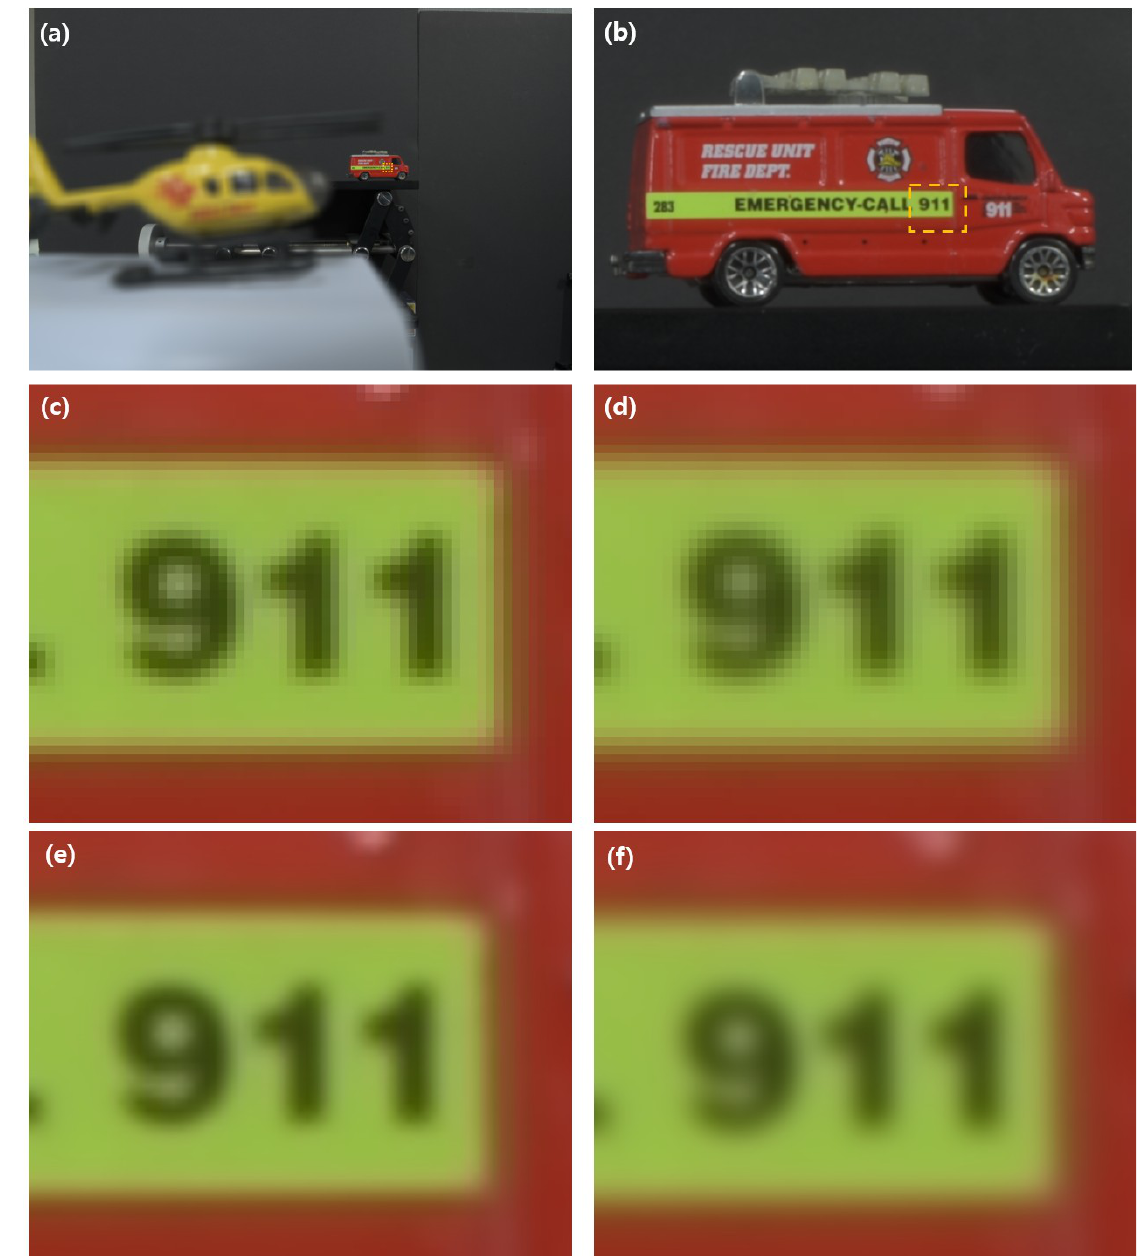
Figure 11. ( a ) Reconstructed three-dimensional image by conventional method, ( b ) reconstructed three-dimensional image by our proposed method, ( c , d ) cropped image from the results by conven- tional method at 344 mm and 392 mm, and ( e , f ) cropped image from the results by our proposed method at 43 mm and 49 mm,